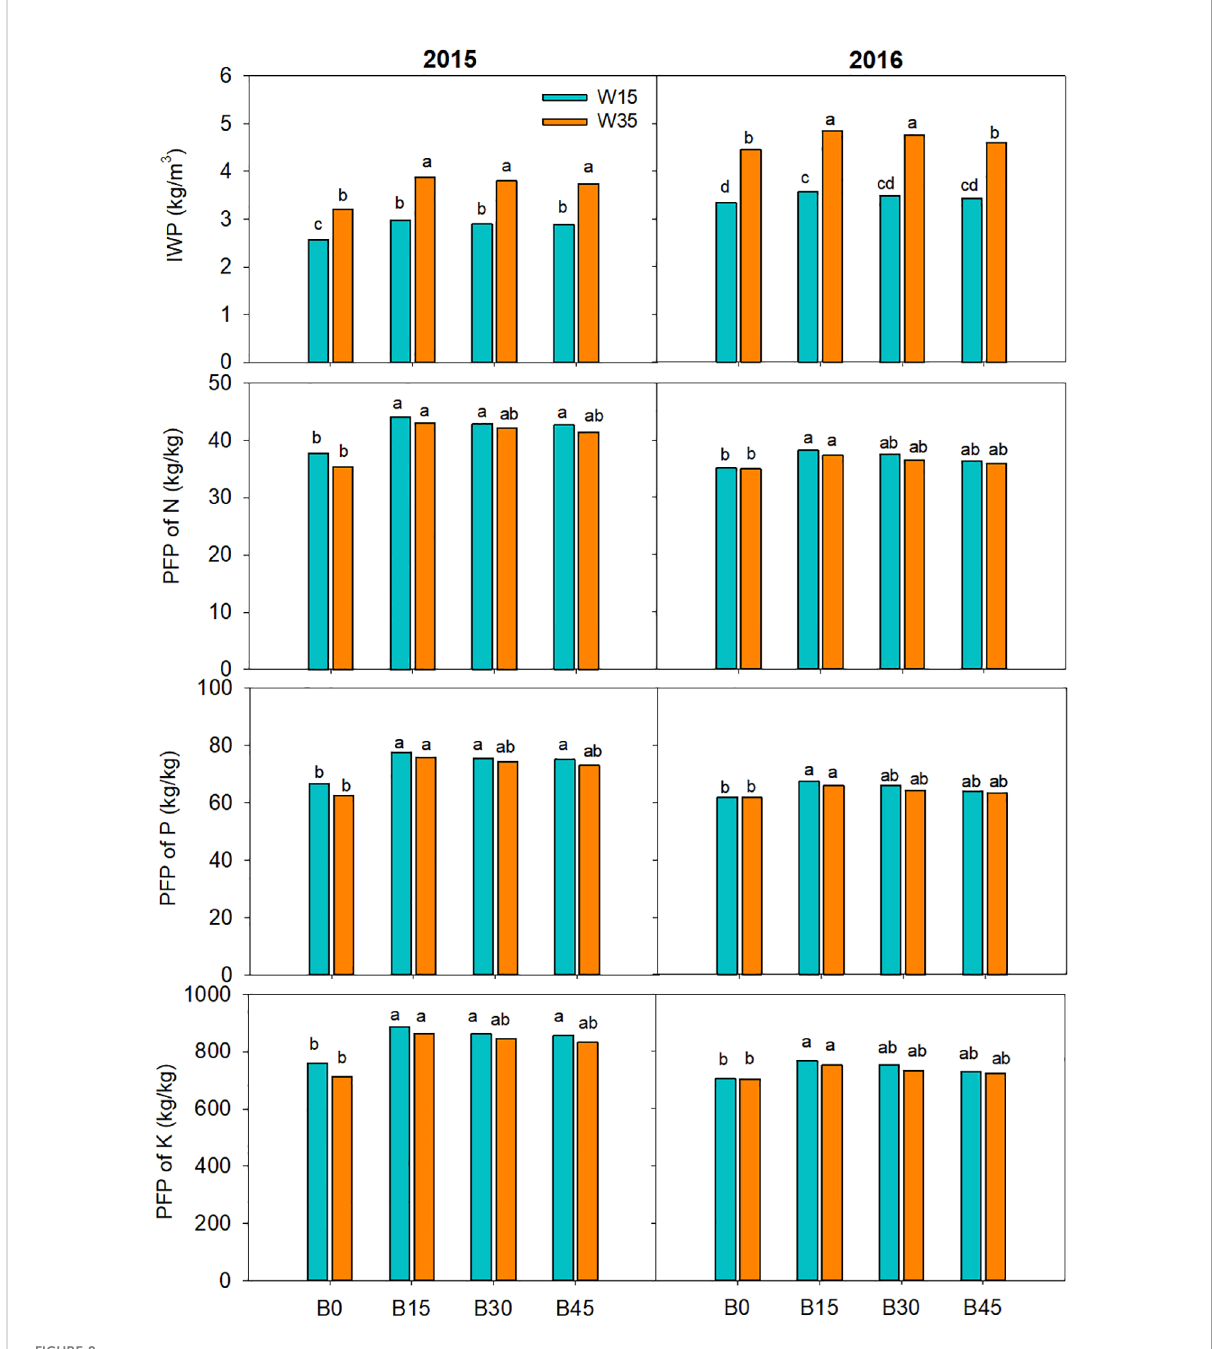
FIGURE 8 Irrigation water productivity (IWP) and partial fertilizer productivity (PFP) of nitrogen, phosphorus, potassium for maize growth under biochar amendments (B0, B15, B30, and B45, referring as 0, 15, 30, and 45 t ha -1 ) and irrigation water lower limits at soil matric potential -15 (W15) and -35 kPa (W35) in 2015 and 2016. Different lowercase represents signi fi cant difference at P<0.05 between